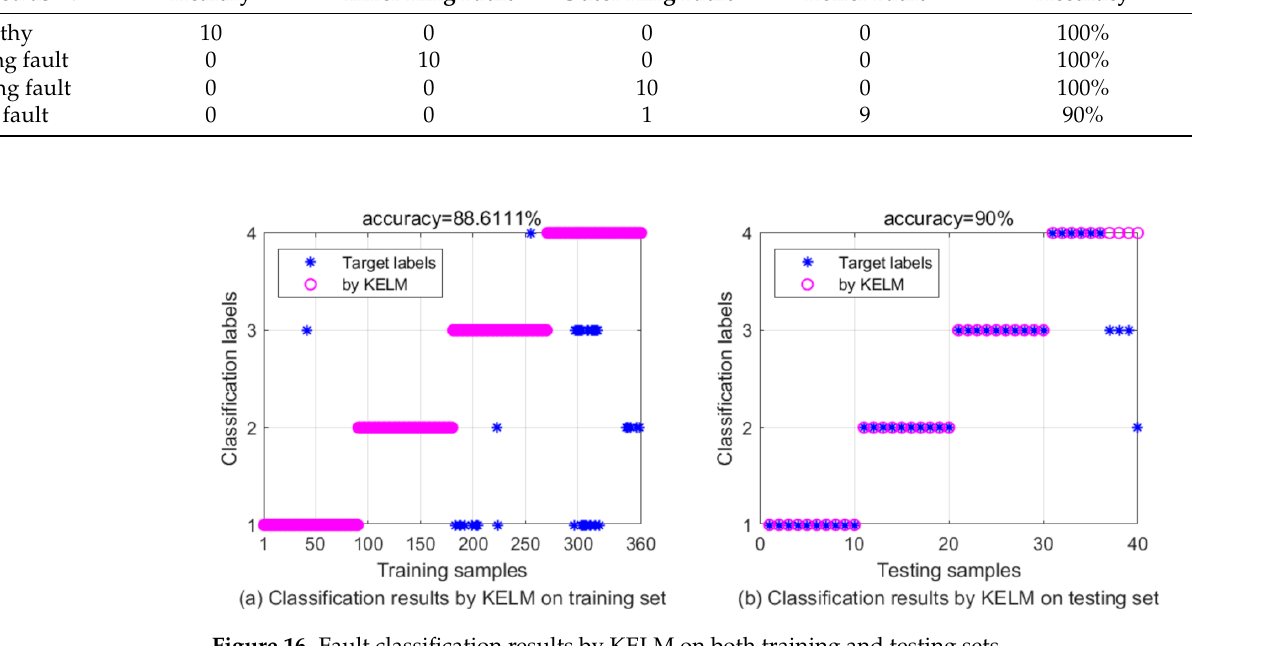
Figure 16. Fault classification results by KELM on both training and testing sets. Table 8. Classification results by KELM of each